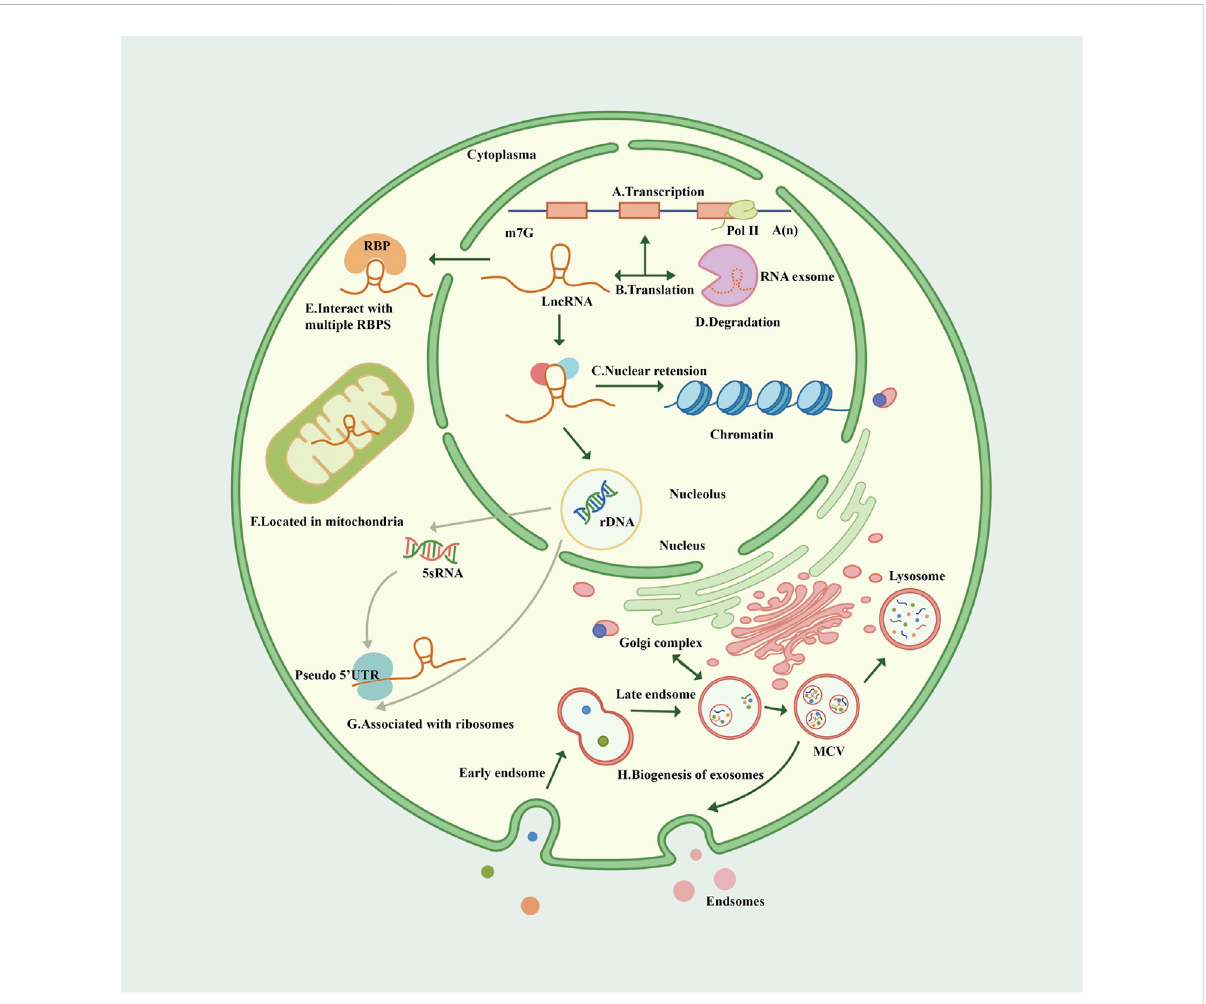
FIGURE 1 Biogenesis and cellular routes of lncRNAs. (A) . The transcription of lncRNA. LncRNA is mainly transcribed by Pol II with a Cap structure at the 5 ′ end and generally a non-characteristic poly A structure at the 3 ′ end. (B) . The translation of lncRNA. Some open reading frames on lncRNA translate some functional peptides and proteins. (C) . LncRNA has nuclear retention and nuclear localization through various mechanisms. (D) . The degradation of lncRNA. Most non-polyadenylated lncRNAs are rapidly degraded by the RNA extracellular complexes, and some lncRNAs are transcribedbydysregulatedPolII,retainedonchromatin,andalsodegradedbyexosomes. (E) .LncRNAsinteractwithmultipleRBPSinthecytoplasm. (F) . Lncrnas are sorted into mitochondria through unknown mechanisms. (G) . Many lncRNAs in the cytoplasm are related to ribosomes through “ pseudo ” 5 ′ untranslated regions (UTRs); Lncrna participates in the process of nucleolus ribosomes, which may explain the fact that lncRNA is associated with ribosomes. (H) . Nanoscale membrane vesicles are released to form exosomes through the fusion of plasma membrane through the